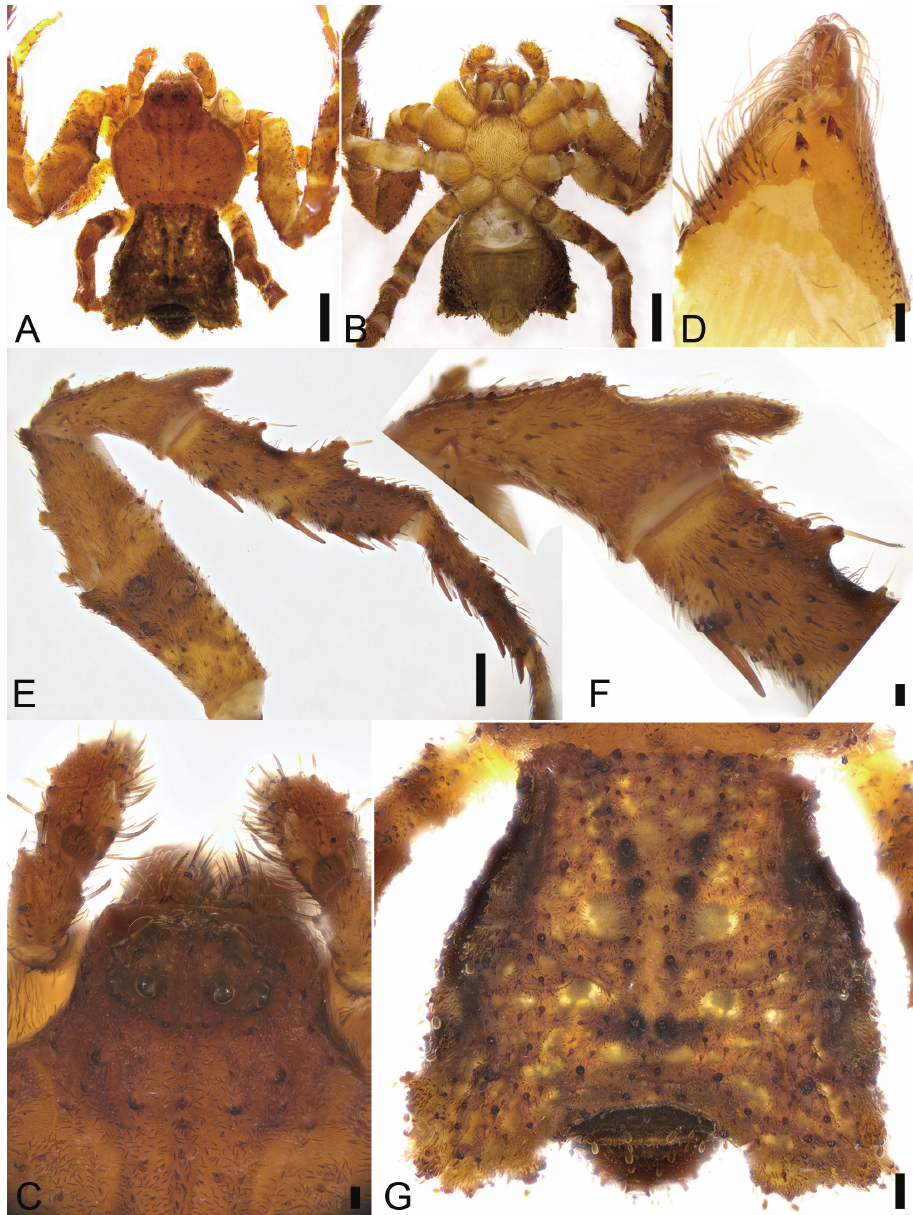
Figure 12. Stephanopis xiangzhouica sp. nov., female holotype. A habitus, dorsal view B same, ventral view C cephalic part, dorsal view D left chelicera, mesal view E left leg I, prolateral view F patella I, prolateral view G abdomen, dorsal view. Scale bars: 1 mm ( A, B ), 0.1 mm ( C, D, F ), 0.5 mm ( E, G